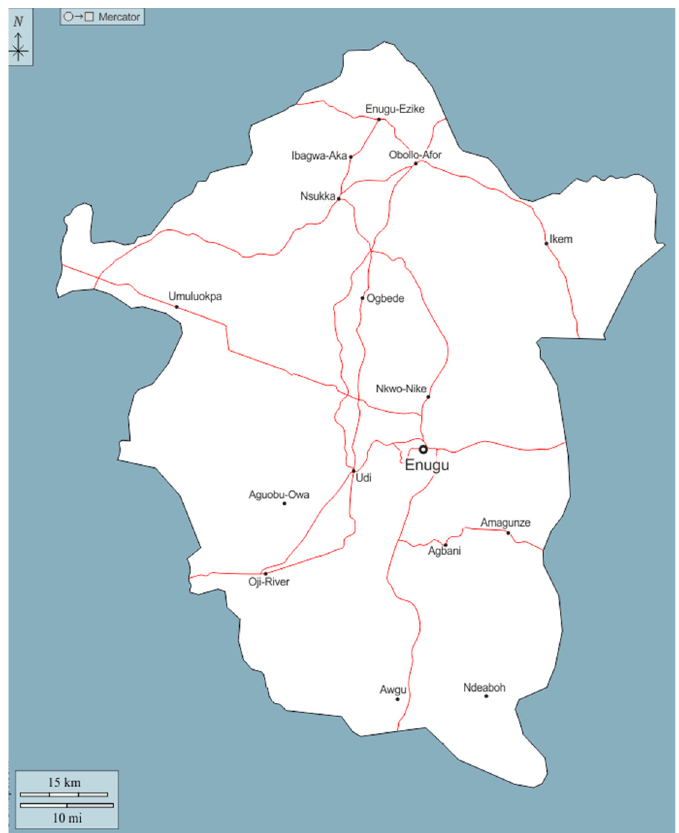
Figure 1. Map showing our pivotal study area in Enugu, Nigeria.